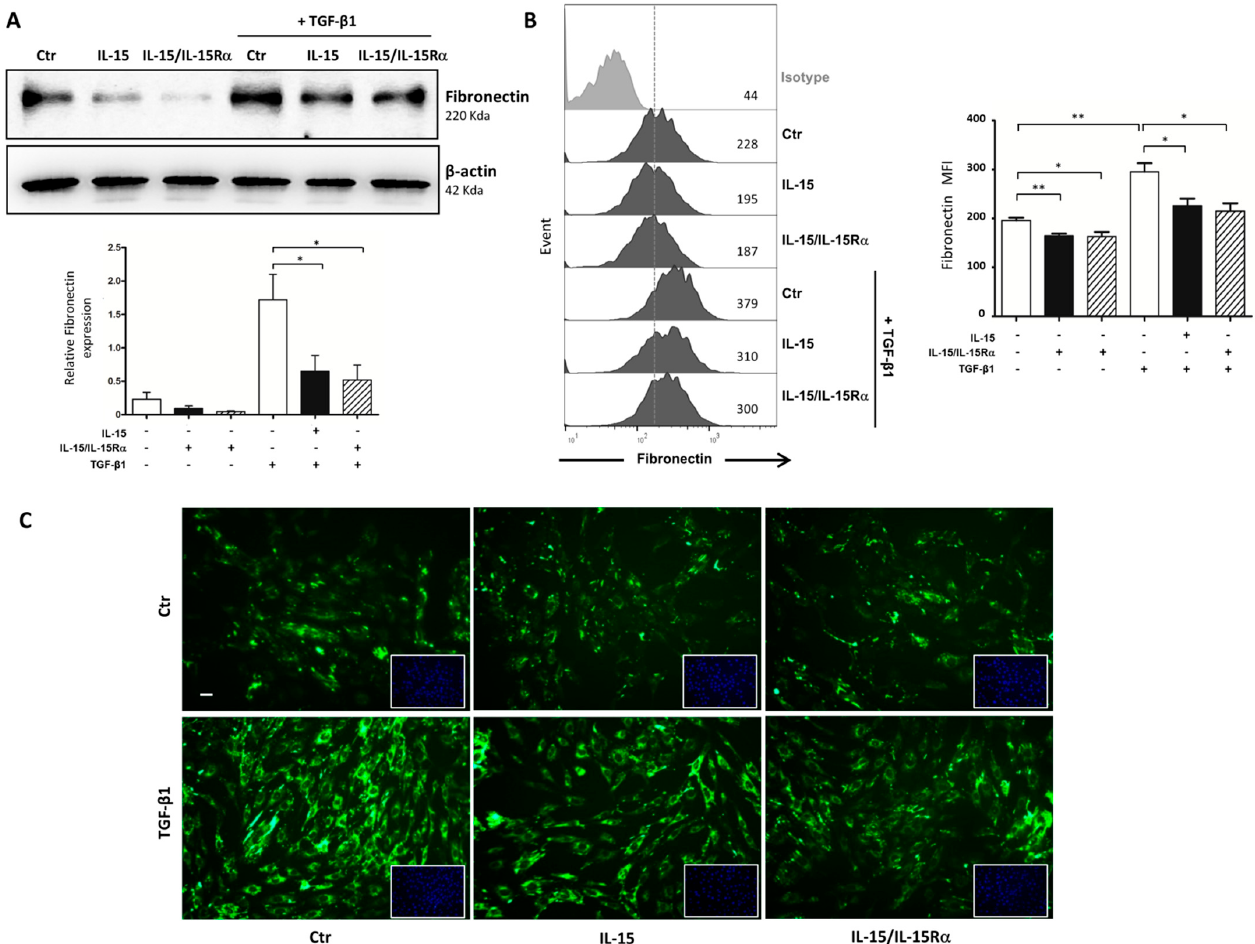
Figure 6. Both IL-15 attenuated fibronectin synthesis and secretion induced by TGF- β 1 stimulation in myofibroblasts. ( A ) Western blot analysis of fibronectin expression after 48 h of TGF- β 1 stimulation (2.5 ng/mL) in the presence or absence of IL-15 alone (2.5 ng/mL) or IL-15/IL-15R α (2.5 ng/mL IL-15 + 15 ng/mL IL-15R α -Fc). Upper, Representative Western blots of one experiment are shown. Lower, Bar chart represents fibronectin expression normalized to β -actin (* p < 0.05, n = 3). ( B ) Intracellular expression of fibronectin was assessed by flow cytometry in 48 h-treated myofibroblasts. Left, Representative staining of one experiment is shown. The dark-colored histograms correspond to cells incubated with an anti-fibronectin antibody, and gray histograms correspond to cells incubated with the isotype-matched control antibody. Mean fluorescence intensity values are shown at the right of each histogram. Right, Graphs represent the relative expression of fibronectin in four independent experiments. Data are shown as means ± SEM (* p < 0.05, ** p < 0.01, n = 4). ( C ) Immunofluorescent staining of fibronectin expression (green) in 48 h-treated myofibroblasts. Nuclei staining with DAPI (blue) was inserted at the bottom right of each image. Scale bars, 20 µm. Data are representative of three independent experiments.